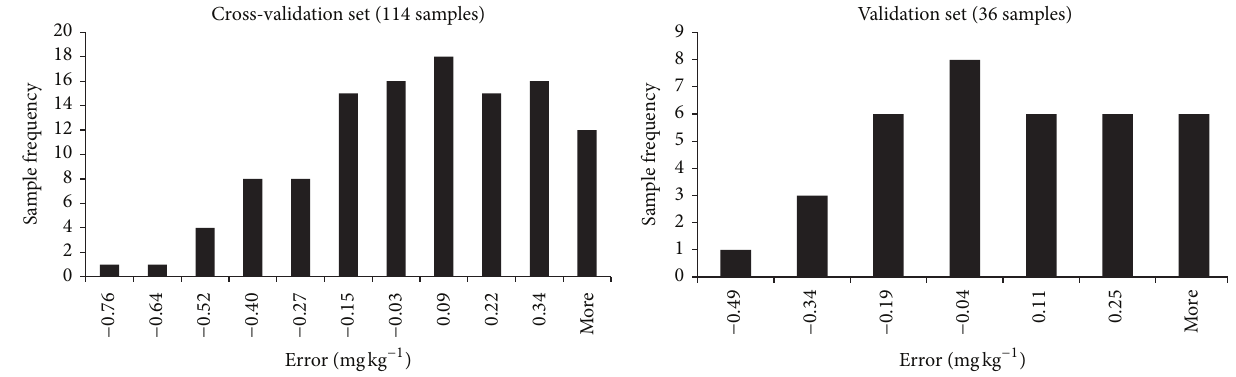
Figure 3: Histogram plot showing the distribution of error between measured and predicted datasets in cross-validation and validation sample sets obtained after PLS regression analysis.